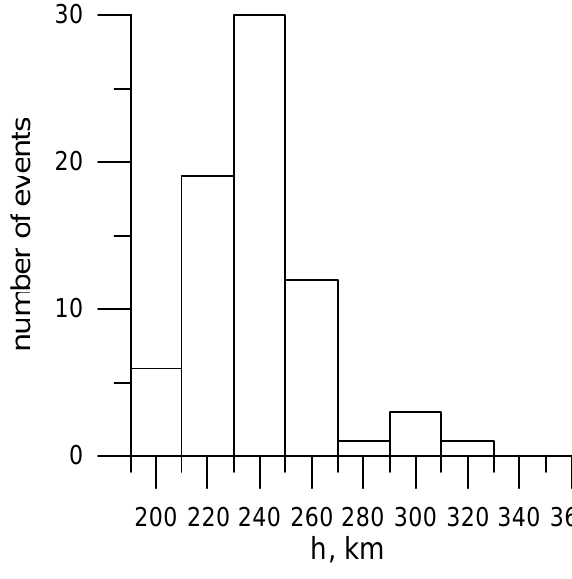
Fig. 7. A distribution of an altitude of the TID’s maximum ampli-